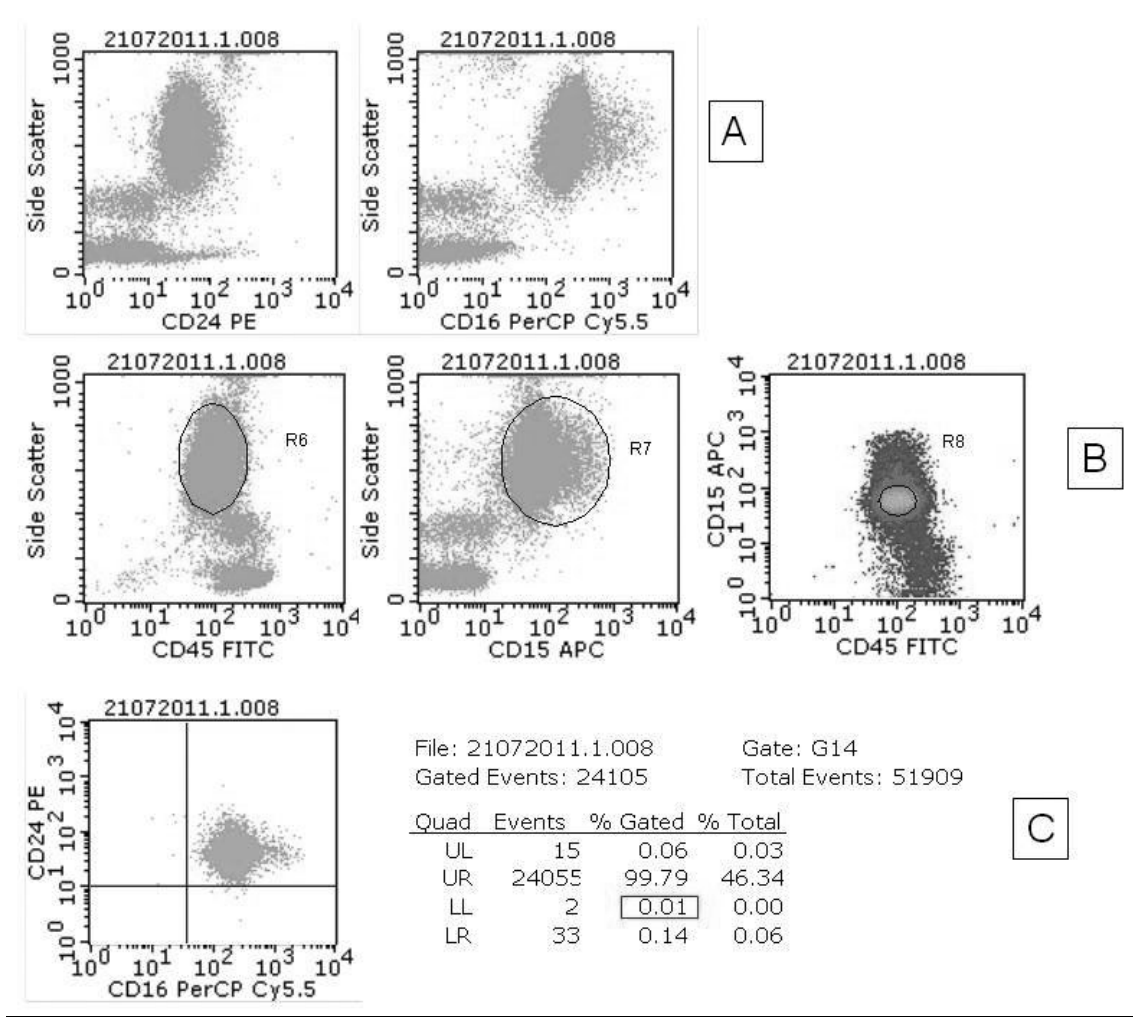
figurE 1 – Analysis, by flow cytometry, of CD24 and CD16 expression in neutrophils of a peripheral blood sample from a control group subject A) acquisition graphs illustrating antigens CD24 and CD16 expression in neutrophils; B) acquisition graphs illustrating antigens CD45 and CD15 expression in neutrophils, used for selection of this cell population, and density graph for the simultaneous assessment of markers CD45 × CD15. Neutrophils were defined based on parameters CD45/ SSC (R6), CD15/SSC (R7) and CD45/CD15 (R8); C) neutrophils of the three combined regions (R6 + R7 + R8 = G14) were assessed for the expression of CD24/CD16. The double-negative population for the markers of interest was identified in the lower left quadrant of dot plot graphs